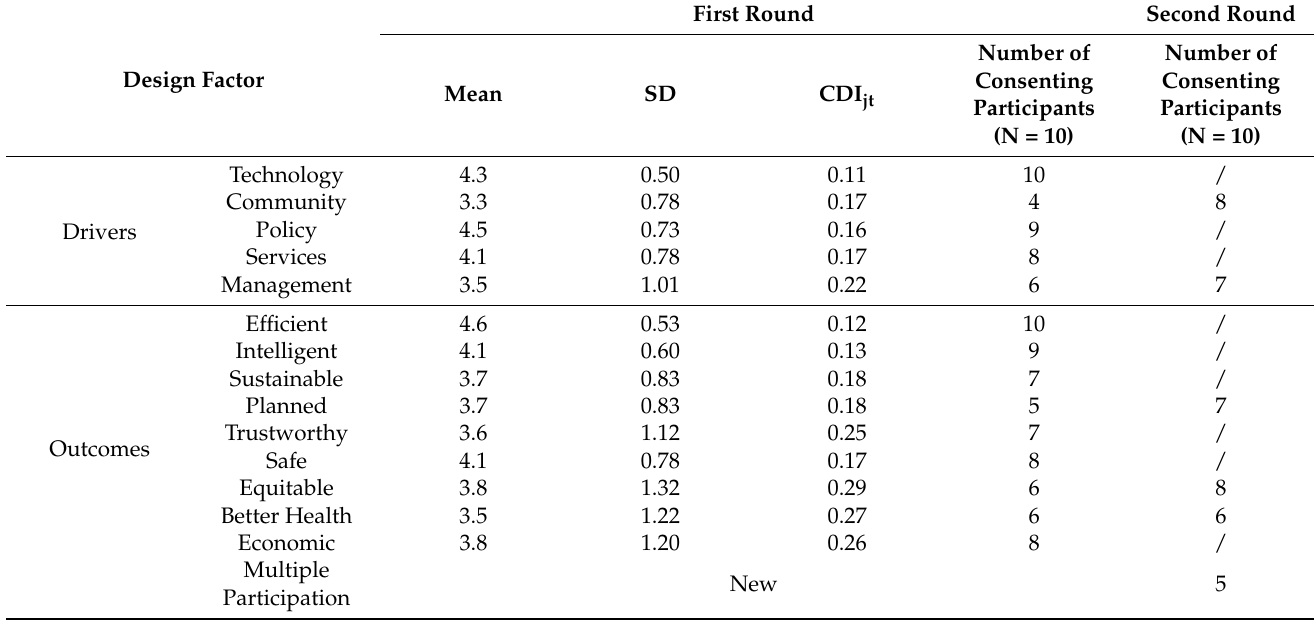
Table 5. Criteria